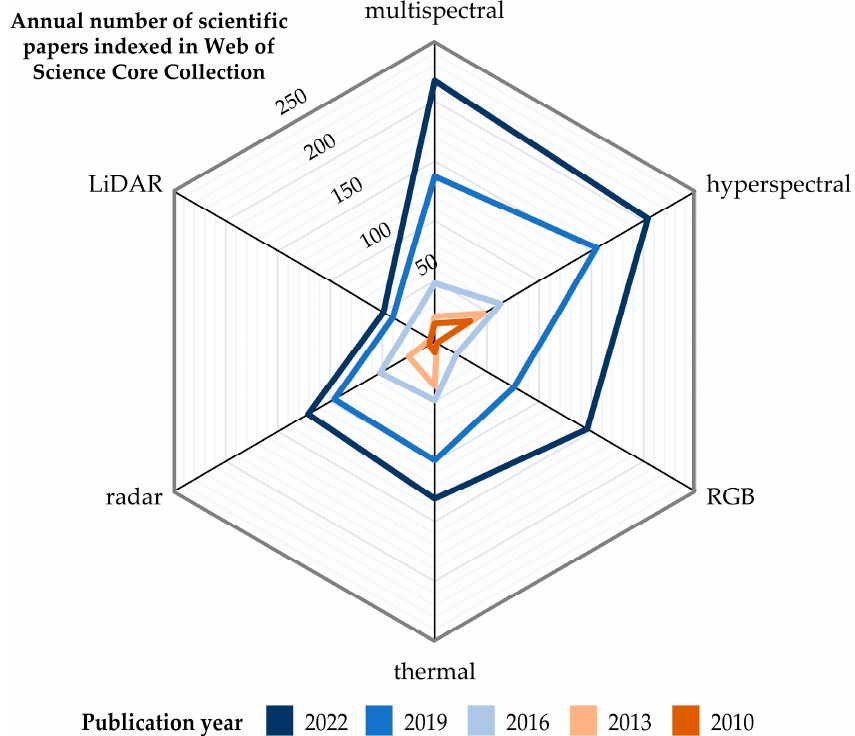
Figure 6. Radar plot of the number of scientific papers indexed in WoSCC since 2010 with the topic of “precision agriculture” AND particular sensor type for each three years.